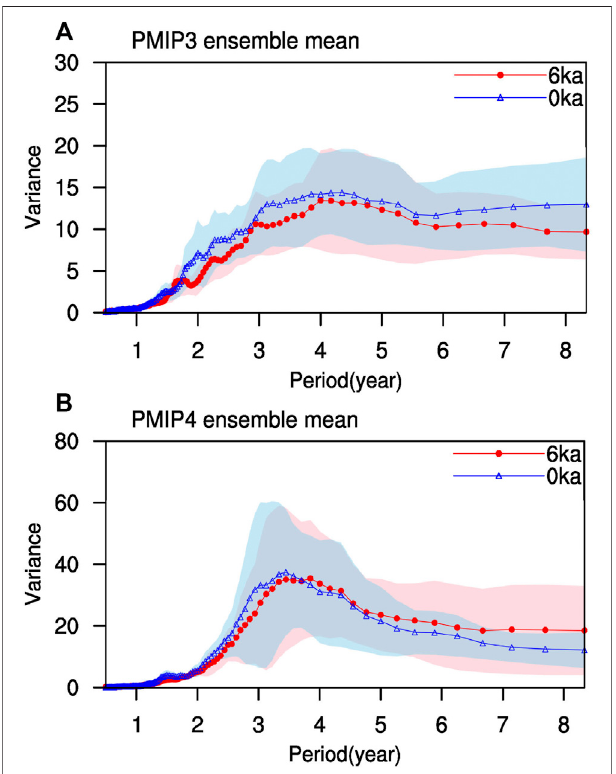
FIGURE 11 | MME of power spectrum derived from (A) PMIP3 and (B) PMIP4 models. Blue and red colors indicate the PI and MH simulations,